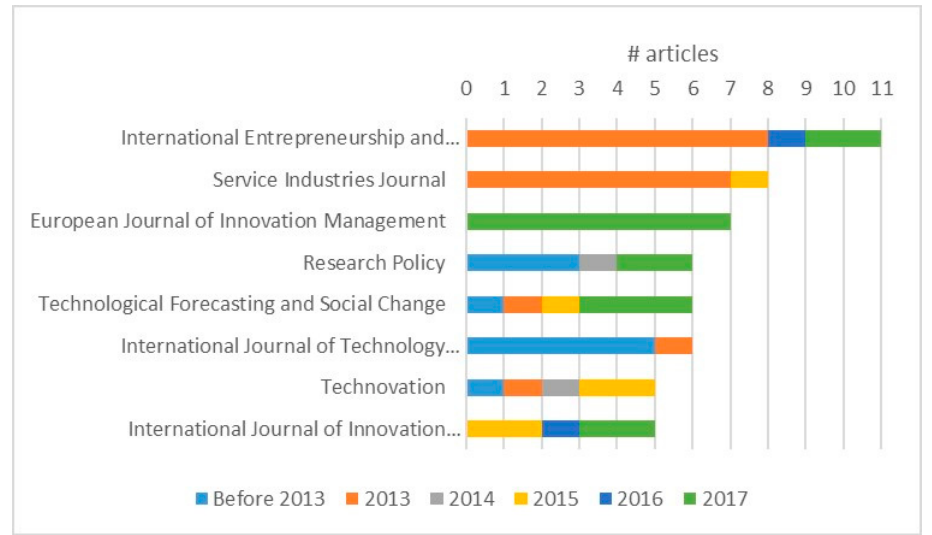
Figure 2. Evolution over time of articles by journal.